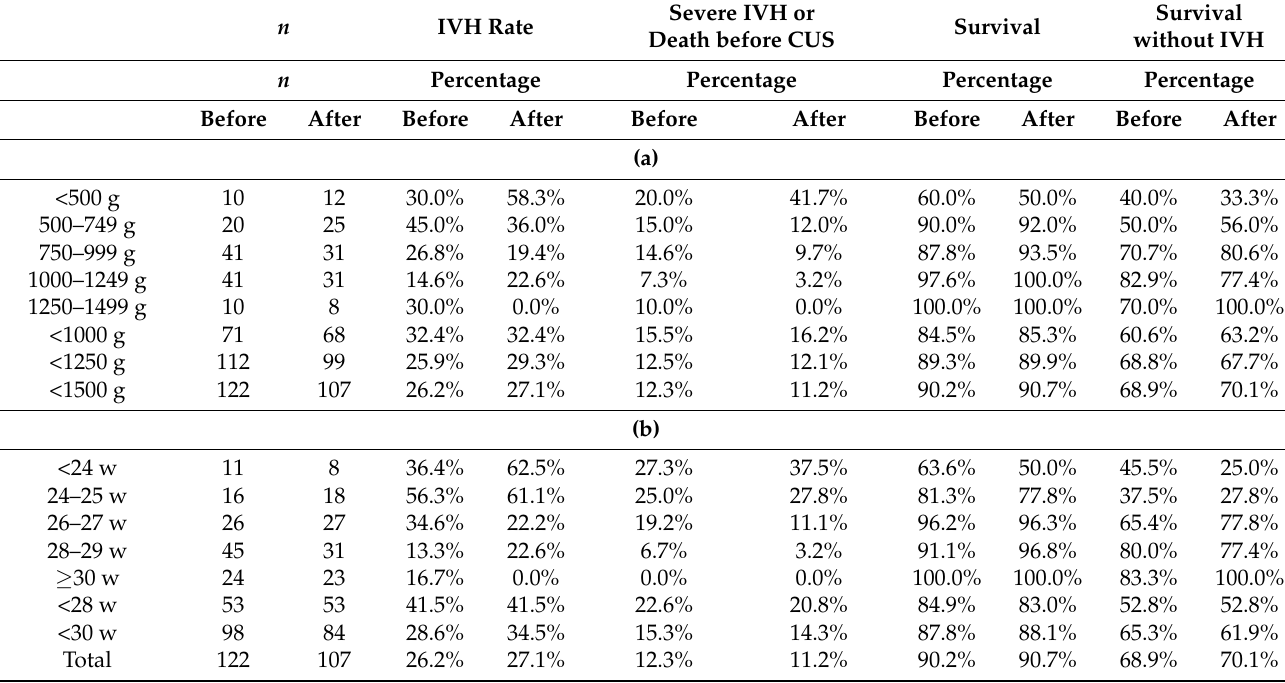
Table 3. IVH and survival rate classified from birth weight and gestational age before and after implementing the